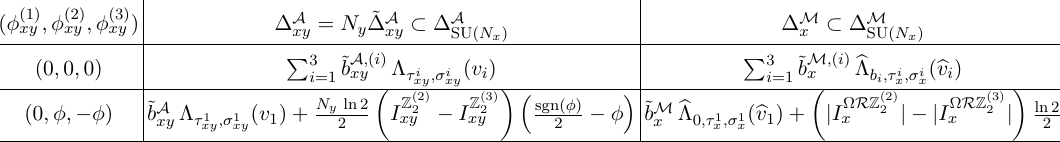
Table 26 . One-loop corrections to the gauge couplings of fractional D6-branes at some vanishing angle on T 6 = ( Z 2 (cid:2) Z 2 M (cid:2) (cid:10) R ) orientifolds with discrete torsion. The annulus lattice sums